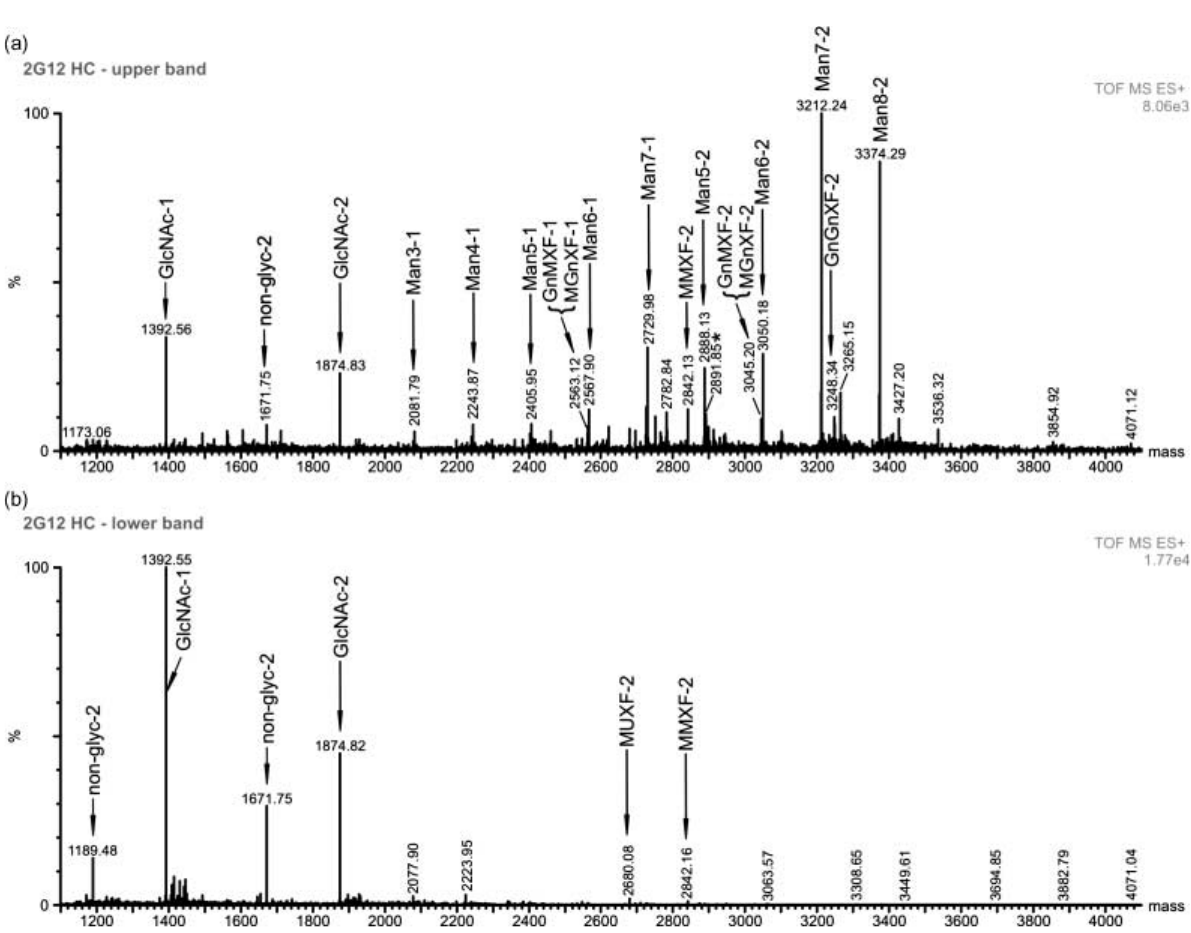
bands were combined prior to analysis. The results, shown in Table 1, are representative of more than five experiments that were carried out with independent samples obtained from different crosses. Only small quantitative variations in the relative amounts of glycoforms were observed.